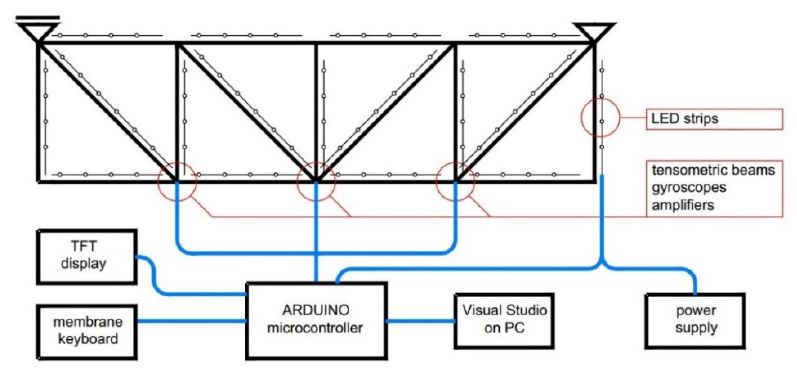
Figure 5. Truss diagram.